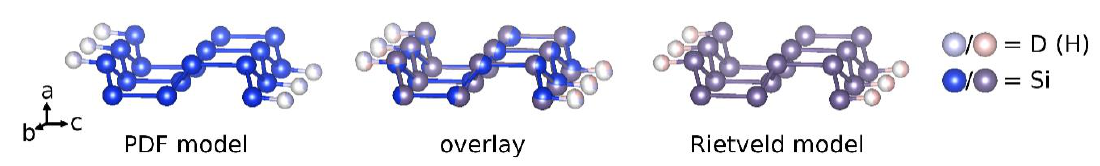
Figure 8. Comparison of the polyanionic structures as determined by the PDF and the Rietveld model (with constrained Si–D distance). The overlay of both models is shown in the middle.